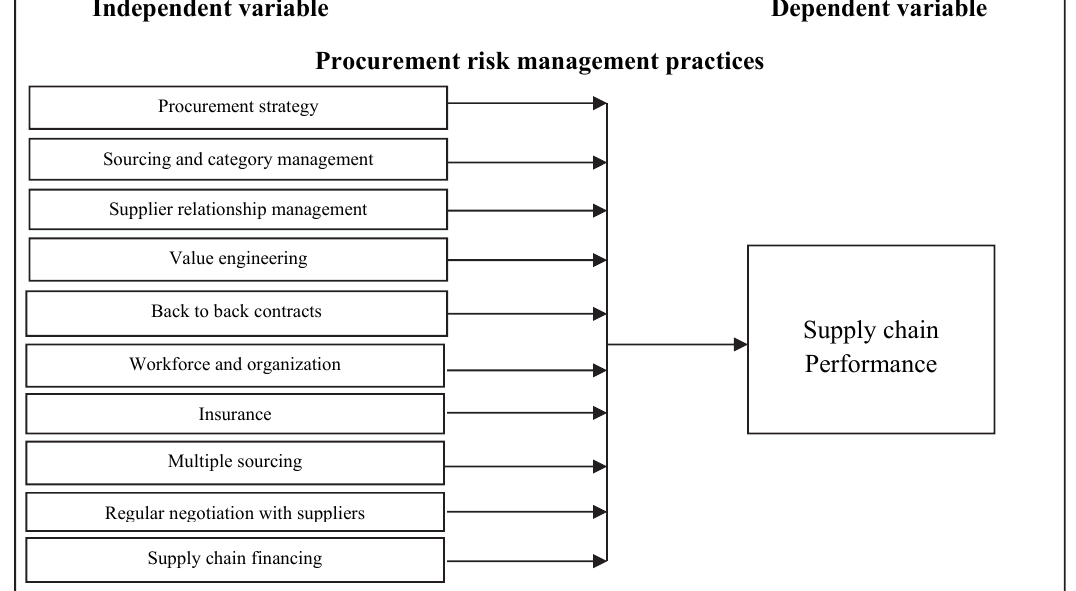
Fig. 1. Conceptual